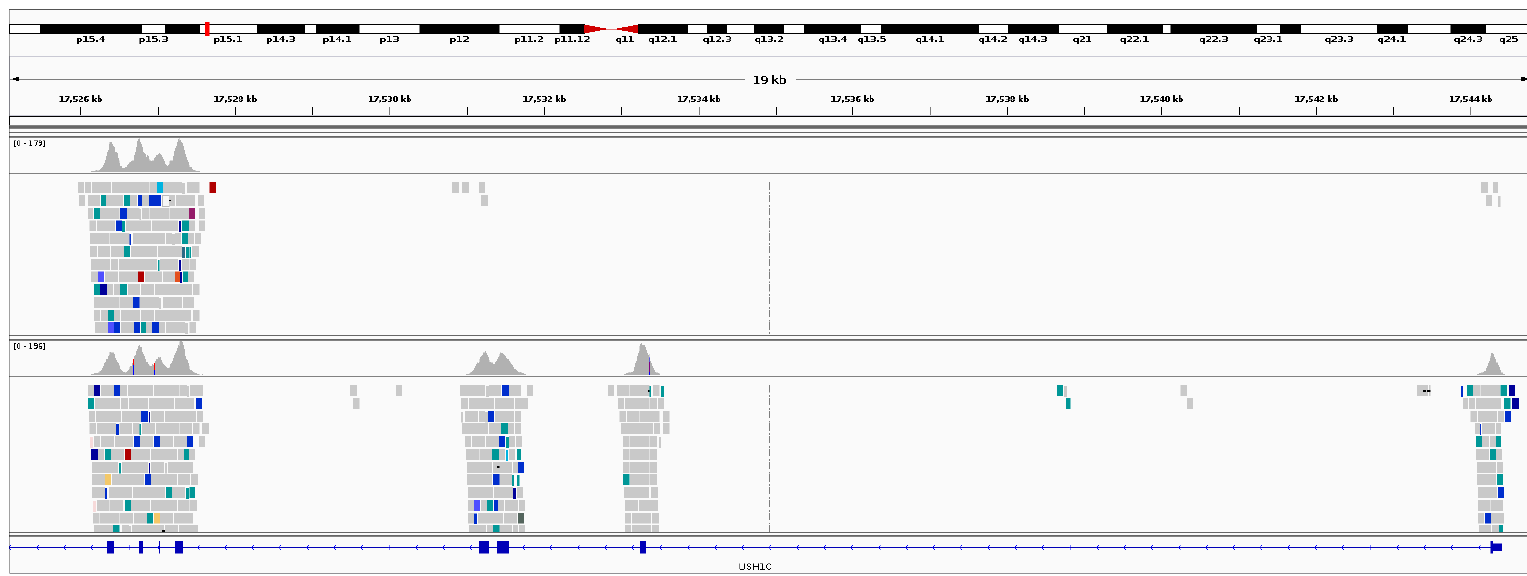
Figure 8. Large homozygous deletion spanning the first four exons of USH1C . In the top panel of reads from the patient sample, it is clear that there was no sequenceable template in this region compared to the control (bottom panel of reads).